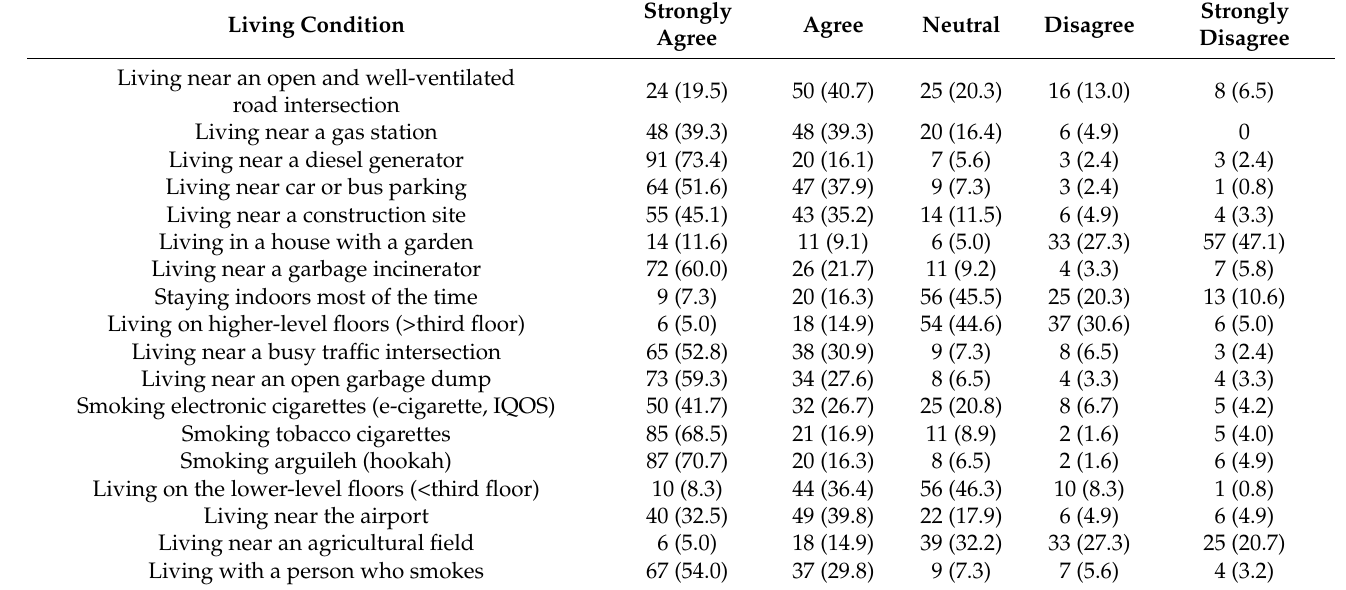
Table 2. Answers to the question “To what extent do you agree that each of the below living conditions is associated with exposure to air pollution”? The answers are reported as true counts (percentage).